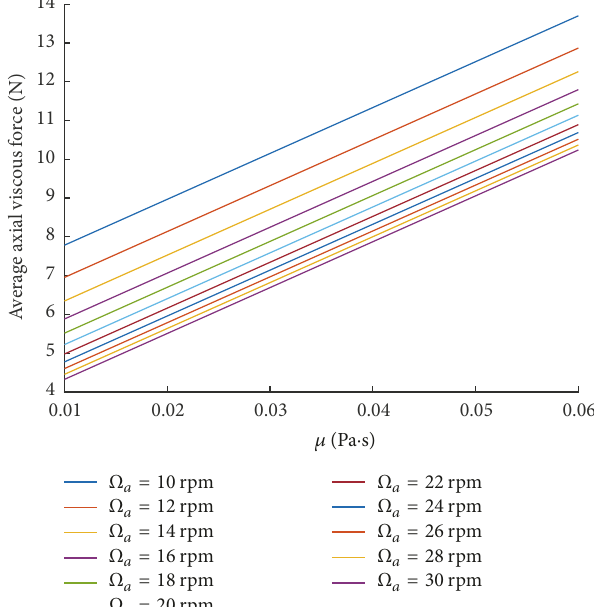
Figure 11: Influence of viscosity of drilling mud on the change in axial viscous